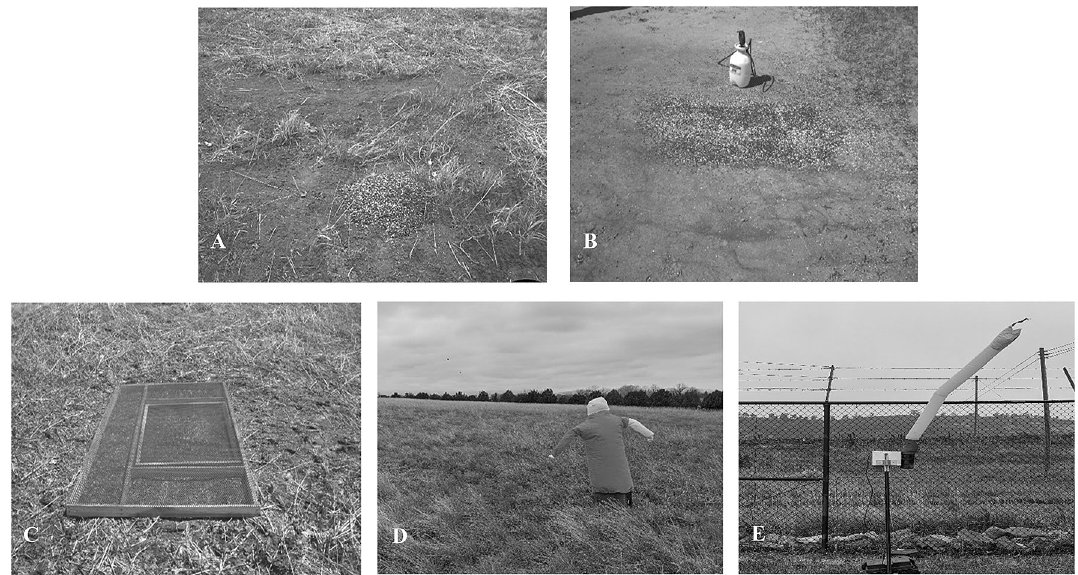
Figure 2. Examples of potential bird deterrents tested in in north-central Colorado, USA during April–May 2020, including ( A ) control, no deterrent, ( B ) 7.5% concentration of methyl anthranilate, ( C ) a metal grate, ( D ), an inflatable scarecrow, and ( E ) a scare dancer. Photos property of